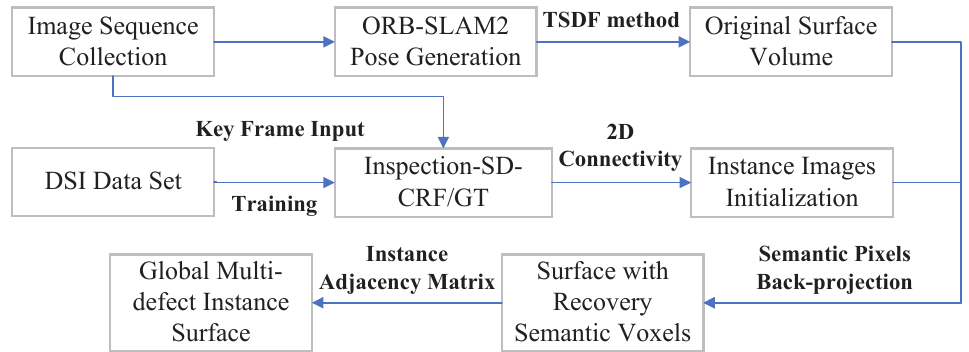
Figure 3. Pipeline of our algorithm.The algorithm is divided into two parts. The sequence images collected by the wall-climbing robot are selected to establish the DSI dataset, and then the deep neural network model is trained. The 3D reconstruction uses the keyframe and pose data of the sequence images to obtain an initial set of surface voxels through the TSDF method. Then, using the principle of connectivity, the semantic image output is initialized as a collection of instance images of different defects. Finally, the back-projection method and the adjacency matrix are applied to restore and fuse the instance